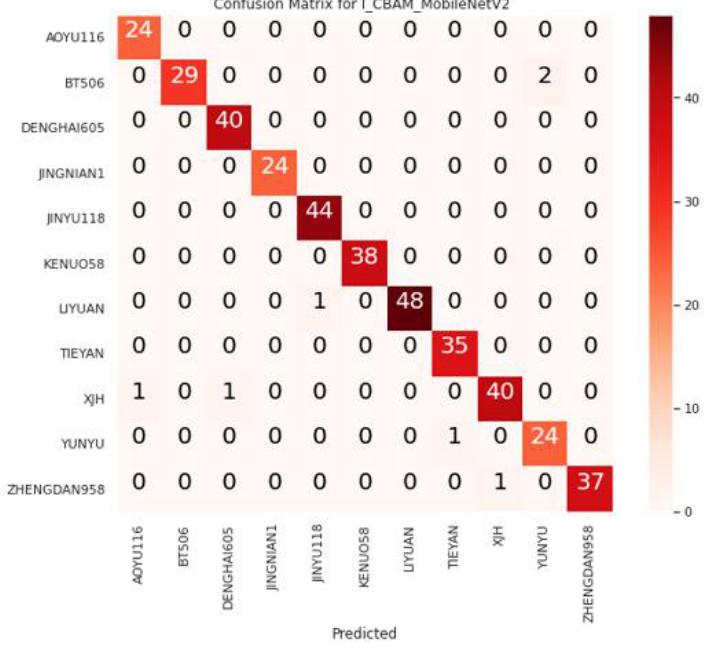
Figure 8. I_CBAM_MobileNetV2 confusion matrix.